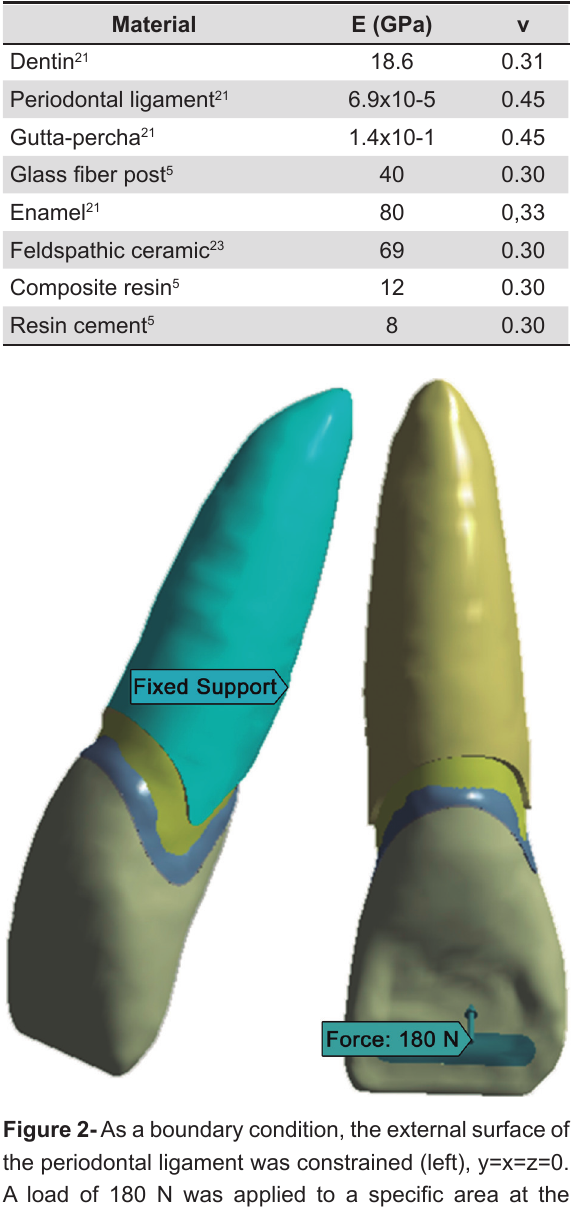
Figure 4- Maximum principal stress (MPa) for various